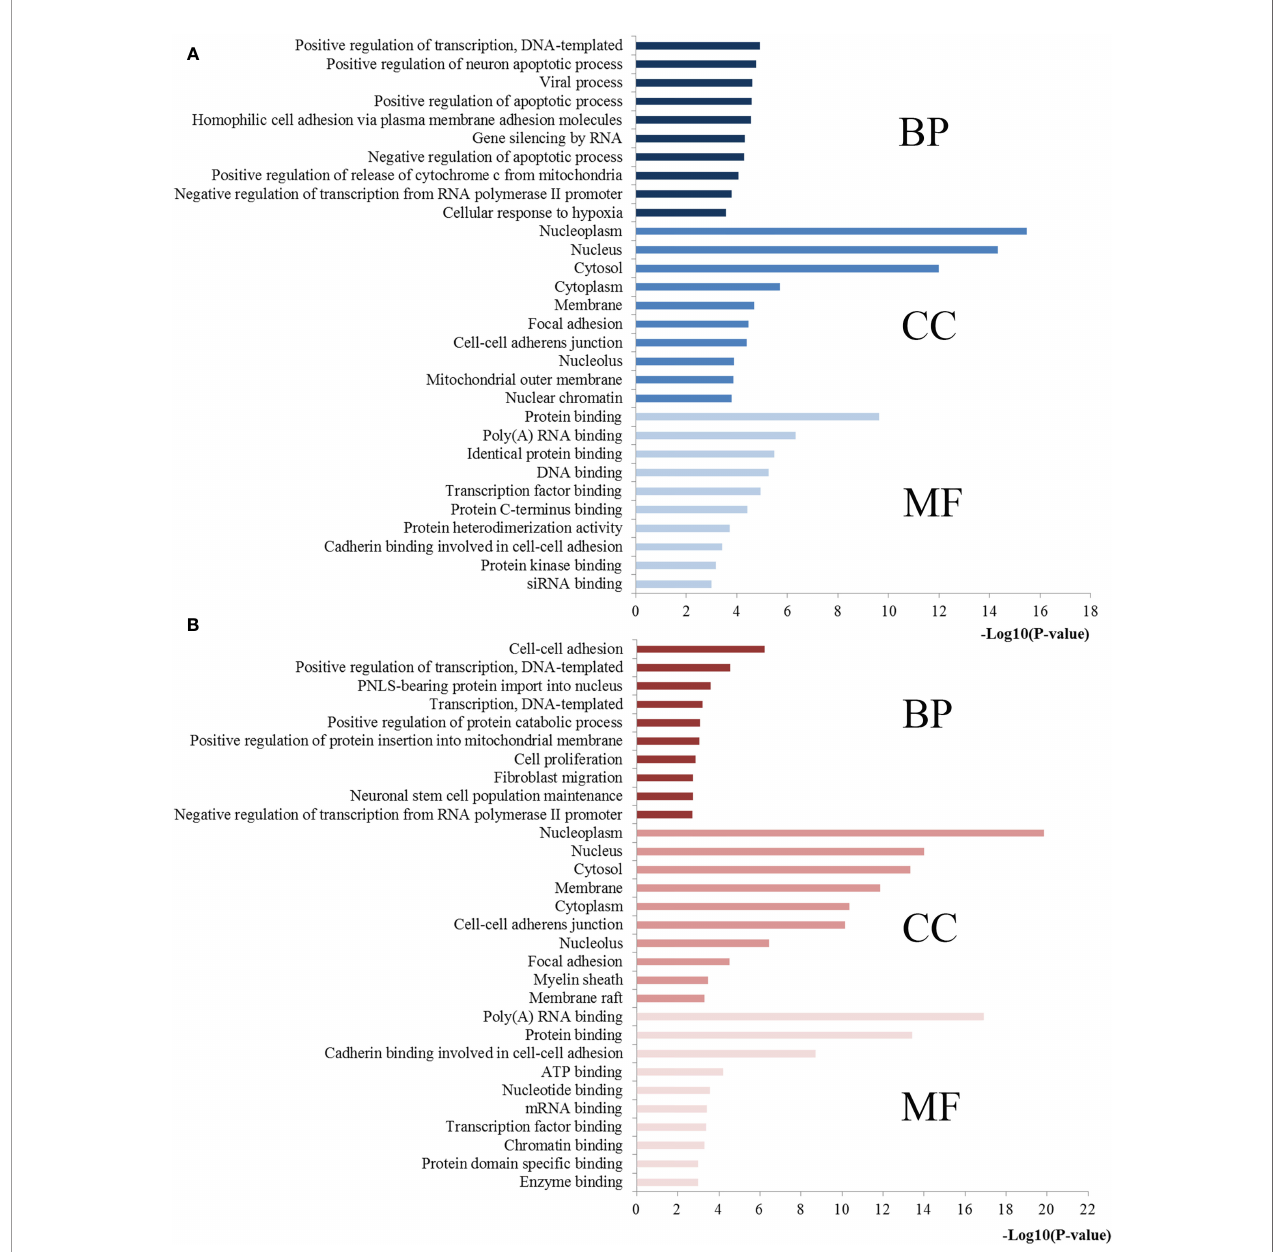
FIGURE 6 | GO annotations of miR-221/222 target genes. (A) Top 10 GO items for target genes of miR-221; (B) Top 10 GO items for target genes of miR-222. GO, gene ontology; BP, biological processes; CC, cell component; MF, molecular